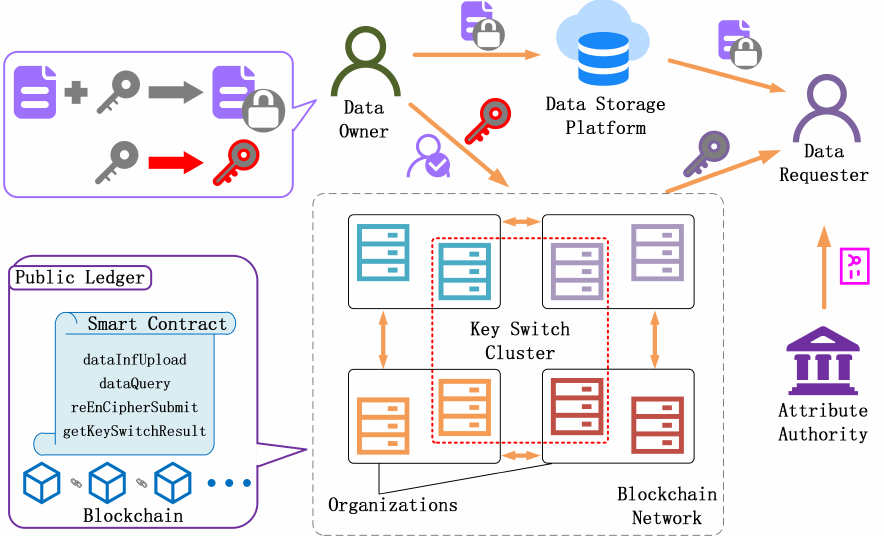
Figure 2. System